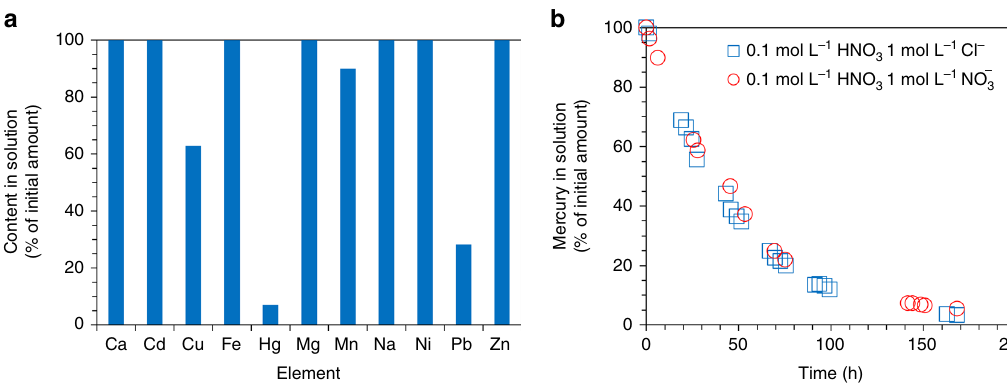
Fig. 4 Selectivity during alloy formation. a Element selectivity during retrieval for 168 h from 50 mL 1 mol L − 1 nitric acid solution containing 10 mg L − 1 of each calcium, cadmium, copper, mercury, magnesium, manganese, sodium, nickel, lead and zinc, and 20 mg L − 1 iron. Working electrode: 100 nm platinum fi lm (2.25 cm 2 area). Counter electrode: platinum wire. Reference electrode: Hg/Hg = 0.16 V vs. RHE. b The decrease of mercury 2 SO 4 . Potential concentration upon electrochemical treatment of (i) 50 mL solution containing 0.1 mol L − 1 nitric acid, 1 mol L − 1 sodium chloride, 10 mg L − 1 divalent mercury (blue squares), and (ii) 50 mL solution containing 0.1 mol L − 1 nitric acid, 1 mol L − 1 [NO 3 − ] as sodium nitrate, and 10 mg L − 1 mercury (red